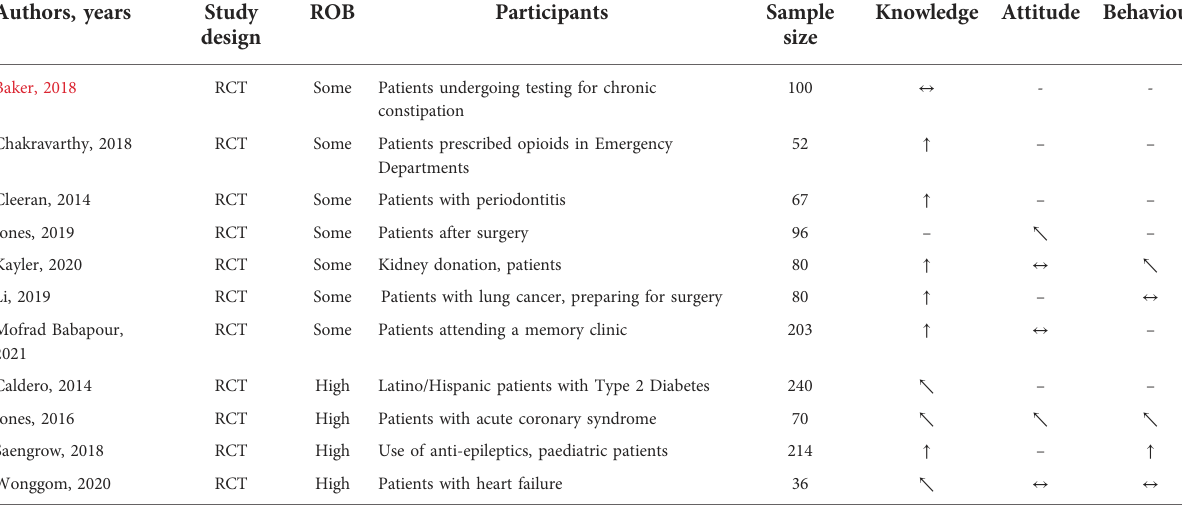
TABLE 2 Category 2 fi ndings (management of long-term